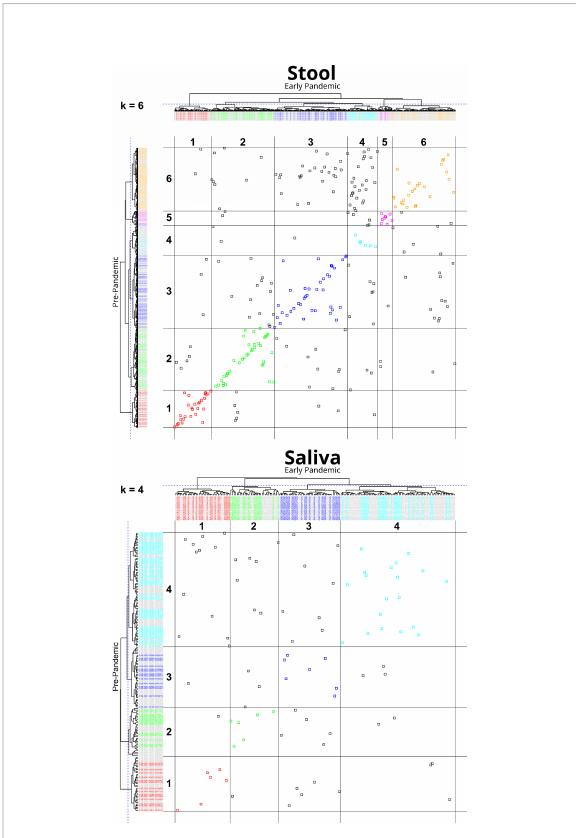
FIGURE 3 Cluster transition plot for Stool at k=6 and Saliva at k=4. Cluster transition plots provide a visualization of the degree to which an early pandemic sample ’ s composition has changed relative to its pre-pandemic composition to warrant a change in its cluster membership. Hierarchical clustering and tree cutting (to form discrete clusters) is inherently an iterative process. In this fi gure, only one slice at k = 6, for stool, and k = 4, for saliva (labeled on the top left of each plot), were selected for illustrative purposes, although cuts k from 2 to 7 were also calculated. The dendrogram from hierarchically clustering of pre- and early pandemic samples are drawn on the top and left margins. The left margin dendrogram have pre-pandemic samples colored by their cluster identi fi er, while early pandemic samples are colored grey. Similarly, but complementarily, the top margin dendrogram has early pandemic samples colored by cluster identi fi er, but pre-pandemic samples are colored grey. In the fi eld of the plot, each point represents the intersection of pre- and early pandemic samples. If both pre- and early pandemic samples are in the same cluster, then they are colored by their cluster identity, otherwise they are colored grey. Gridlines are drawn in the fi eld to help identify cluster boundaries. When pre- to early pandemic samples have changed less in their composition, their points will be colored and lie across a diagonal from bottom-left to top-right. Examples of noteworthy observations from the stool transition plot includes the number of pre-pandemic cluster 6 ( Bacteroides and Escherichia Shigella ) members that have moved into cluster 4 ( Bacteroides , Faecalibacterium ) early pandemic, or that none of the pre-pandemic members of cluster 1 ( Prevotella , Prevotellaceae , and Lactobacillus ) have moved into cluster 6. Comparing the stool and saliva cluster transition plots provides a visualization of the stronger coherence of early pandemic samples to their pre-pandemic counterparts in